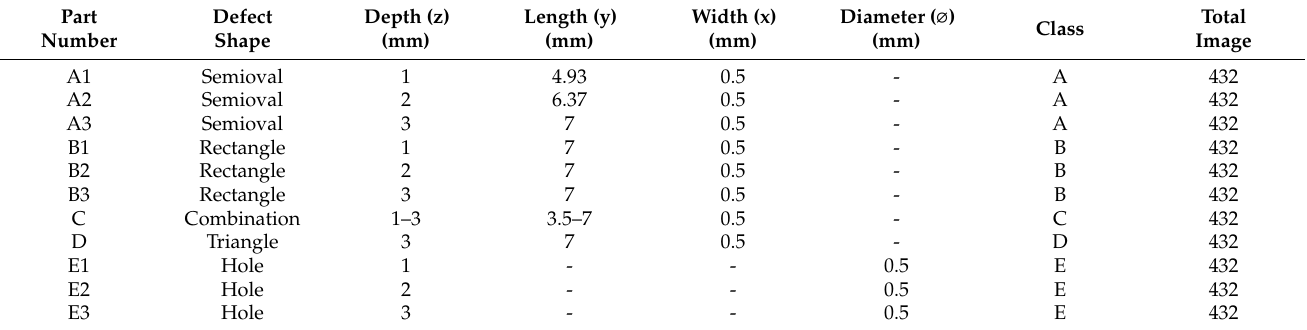
Table 2. Properties of the specimen and geometry of the defect for the MONDI experiment.